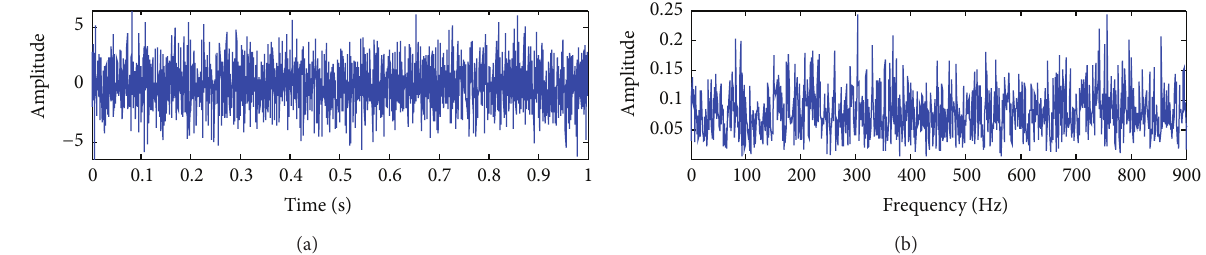
Figure 5: Simulation signal: (a) time-domain waveform and (b) frequency spectrum.